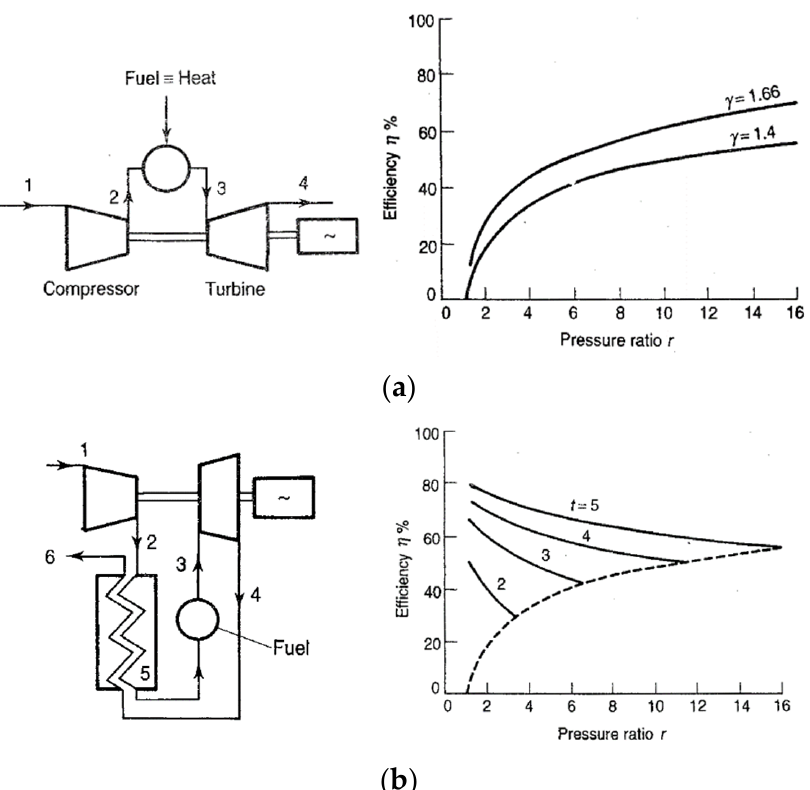
Figure 8. Cycle efficiency based on pressure ratio, ( a ) simple cycle, ( b ) regenerative cycle [49]. In schematic diagrams of gas turbine cycles in ( a , b ), the numbered locations are: 1. engine inlet, 2. compressor outlet, 3. combustor outlet, 4, turbine outlet. additional locations in ( b ): 5. recuperator outlet—cold-side and 6. recuperator outlet—hot-side. In efficiency diagram of ( b ) t is defined as ration of turbine inlet temperature to engine inlet temperature.